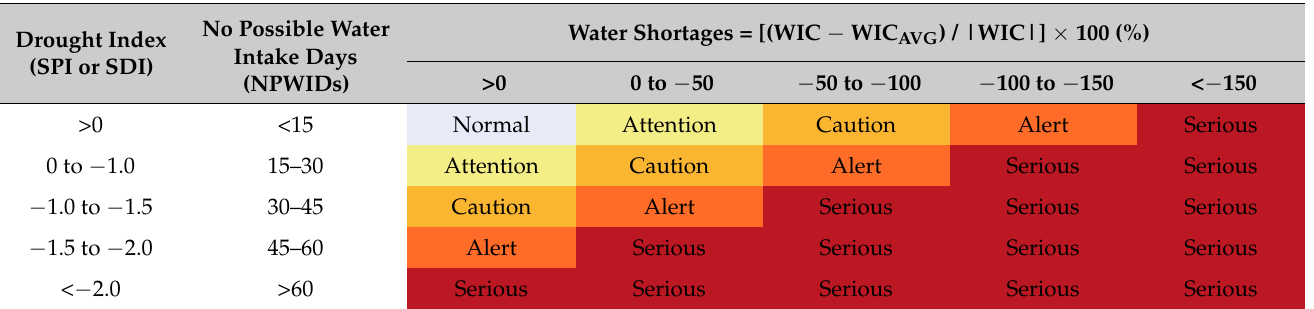
Grey to red color representing the drought conditions from stage one to stage five.